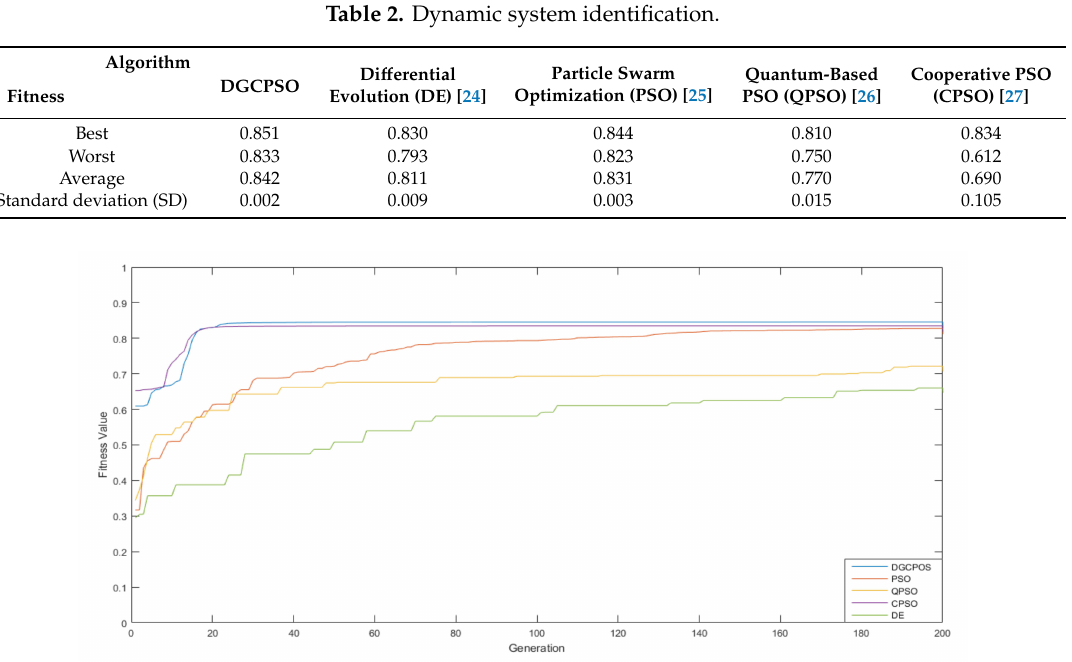
Figure 9. Learning curves of dynamic system